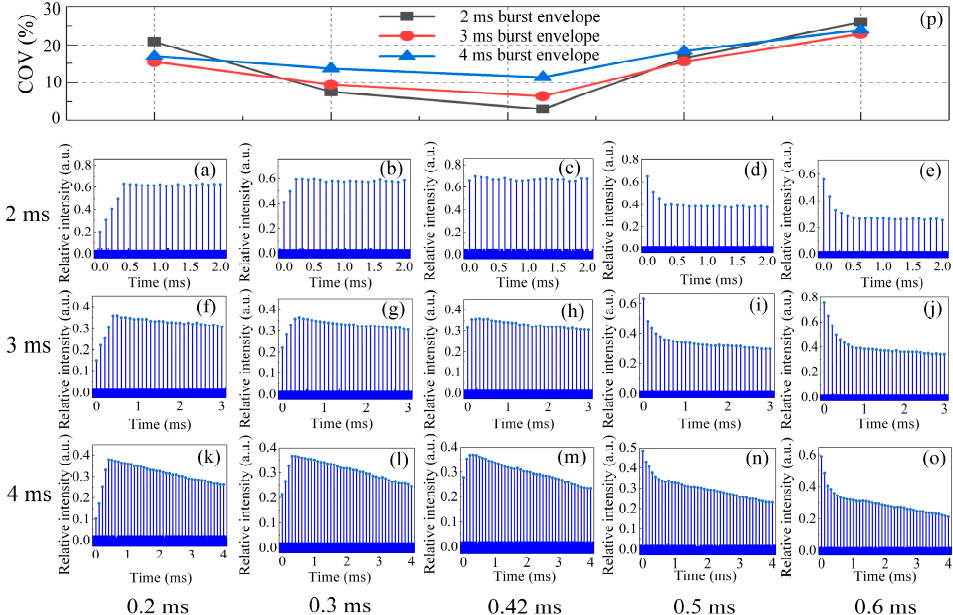
Figure 4. Recorded output burst profile and COV distribution for uniform input at amplification delays of 0.2 ms to 0.6 ms over variable envelope durations: ( a – e ) 2 ms burst profile; ( f – j ) 3 ms burst profile; ( k – o ) 4 ms burst profile; ( p ) COV distribution versus amplification delay at different envelope durations.